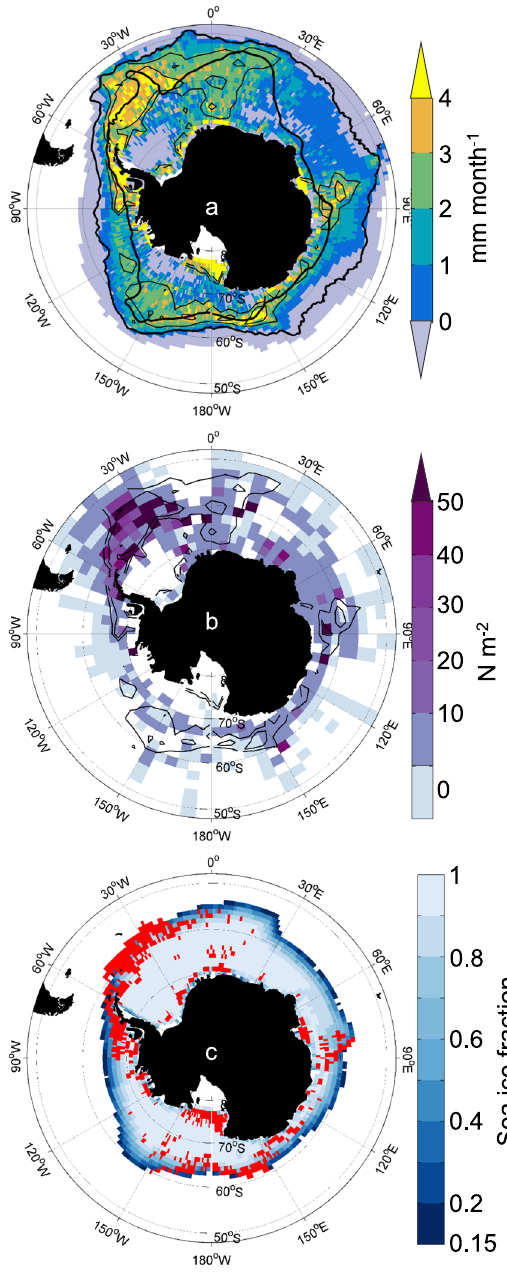
Figure 6. Circumpolar distributions: ( a ) Mean monthly potential growth rate of 40 mm krill for November to March (mm month − 1 ); cells with missing data for chl a set to 0 mg m − 3 . White shading indicates cells with missing environmental data or temperature > 5 °C. Contours of mean growth rate of 2 mm month − 1 and 3 mm month − 1 are derived from a smoothed version of the growth matrix (5° lon × 2° lat; thin black lines). Superimposed with mean positions of Antarctic Circumpolar Current (ACC) fronts 70–72 : Polar Front and southern boundary of the ACC (thick black lines). ( b ) Abundance of krill (N m − 2 ) from KRILLBASE 69 overlaid with contours of mean growth rate of 2 mm month − 1 and 3 mm month − 1 from Fig. 6a (thin black lines). ( c ) Regions where mean monthly potential growth rate of 40 mm krill over November to March exceeding 3 mm month − 1 (from Fig. 6a) coincides with sea ice fraction in range 0.15 to 0.75 in any month (red). Background shading shows climatological mean sea ice fraction for October. Figure created with Matlab software version R2013a (www.mathworks.com) using M_Map mapping toolbox version 1.4f (https://www.eoas.ubc.ca/~rich/